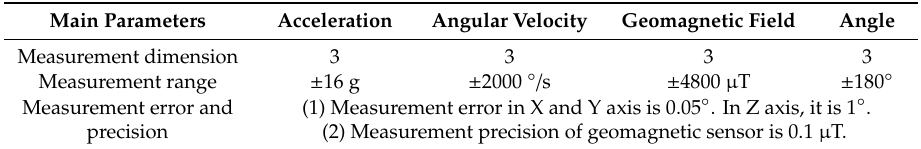
Table 2. Main parameters of the sensor module.